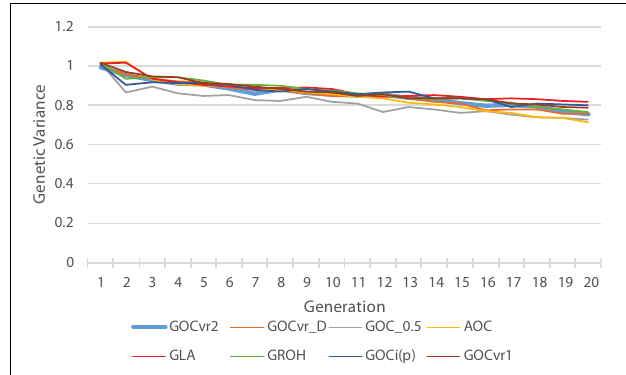
FIGURE 6 | The trait genetic variance of the individuals plotted over time.